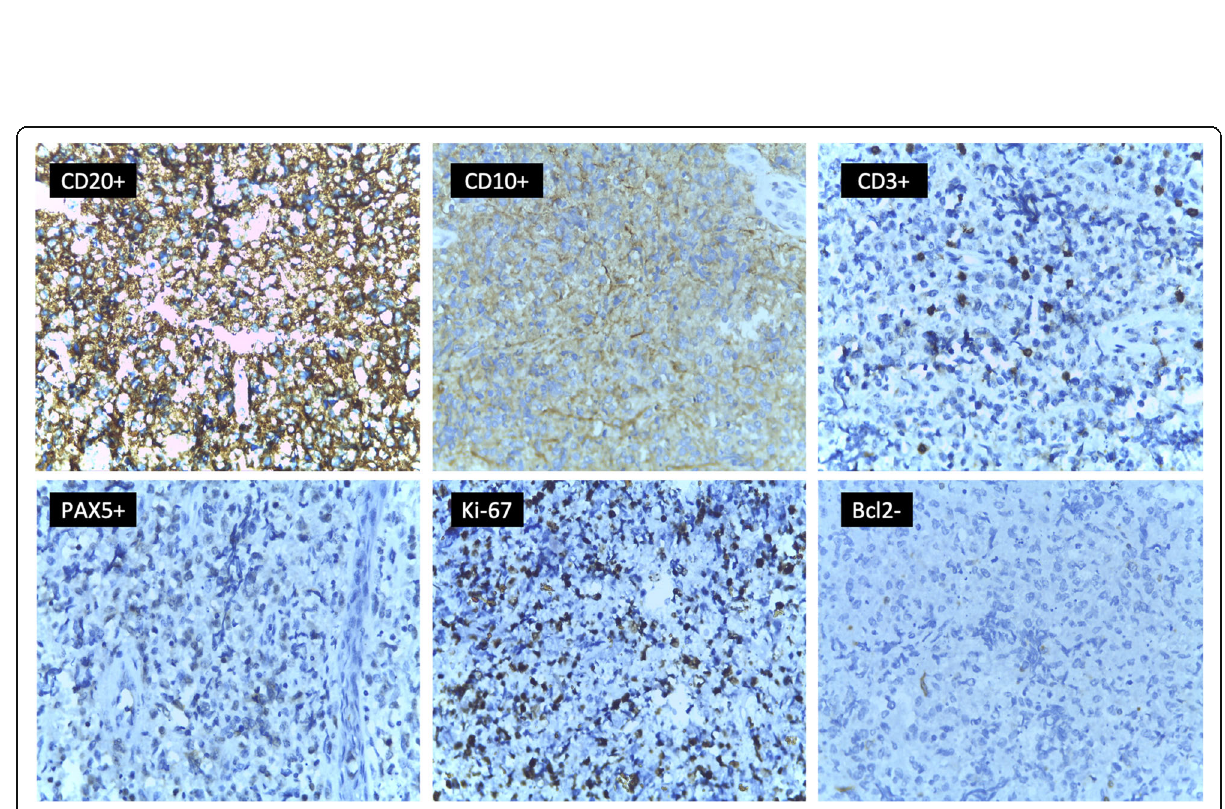
Fig. 2 Immunohistochemistry showing the atypical cells positive for CD20, CD 10, CD3, PAX 5, Ki-67 index of > 60% and negative for